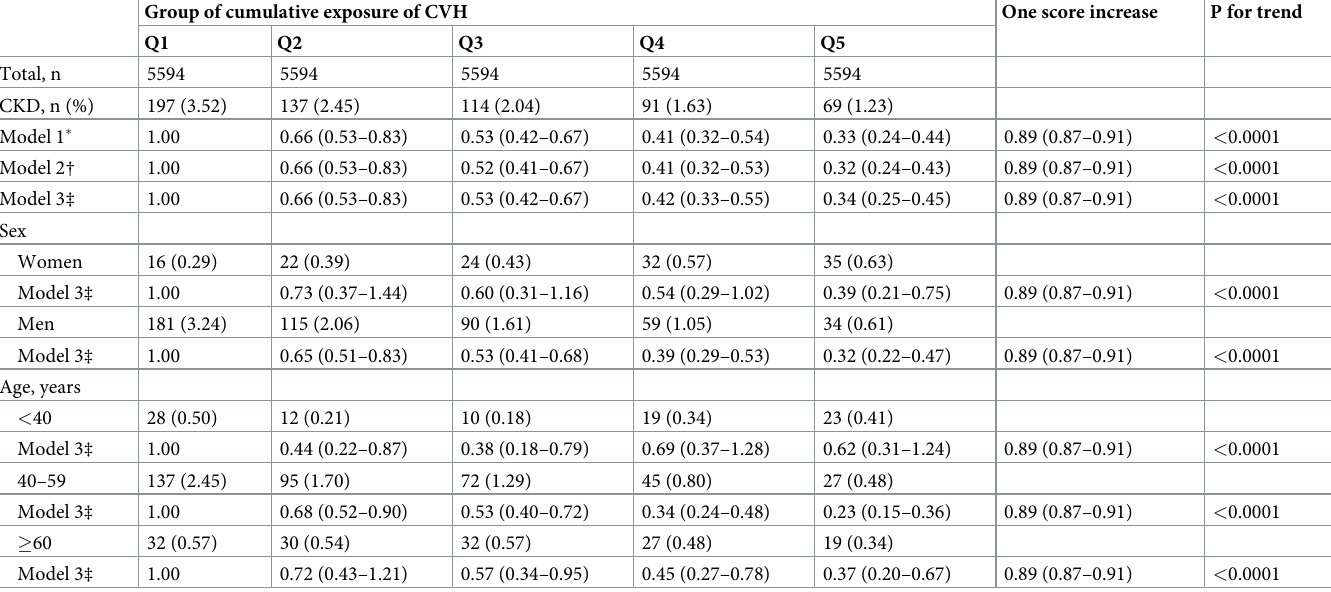
Table 3. Odds ratios and 95% confident intervals of CKD according to the time weighted cumulative exposure of CVH. Group of cumulative exposure of CVH